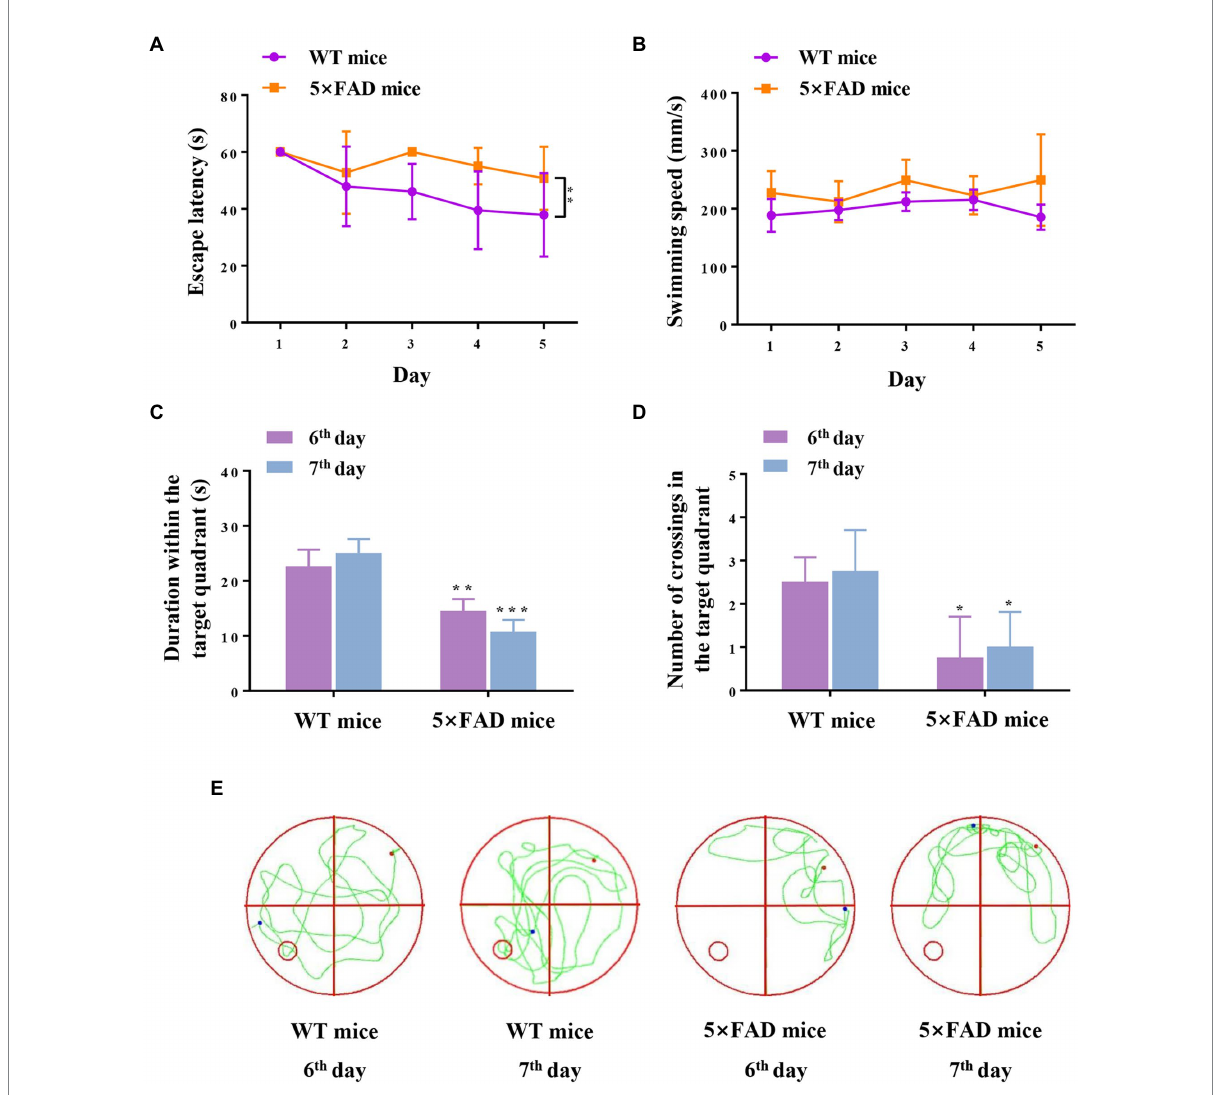
FIGURE 2 Cognition and memory capabilities in WT and 5 × FAD mice. (A) Escape latency of mice during five-day navigation training in MWM test. (B) Swimming speed during five-day navigation training in MWM test. (C) Duration within the target quadrant in space memory trials on the 6th and 7th days. (D) Number of crossings through the original platform position in space memory trials on the 6th and 7th days. (E) Representative traces of mice in the spatial probe test on the 6th and 7th days. The red dots indicate the position of the mouse at the beginning of the spatial exploration trial, the blue dots indicate the position of the mouse at the end of the 60-s trial, and the green line indicates the representative traces of mice. Data are displayed as mean ± SD ( n = 3). * p < 0.05, ** p < 0.01, *** p < 0.001 vs. WT